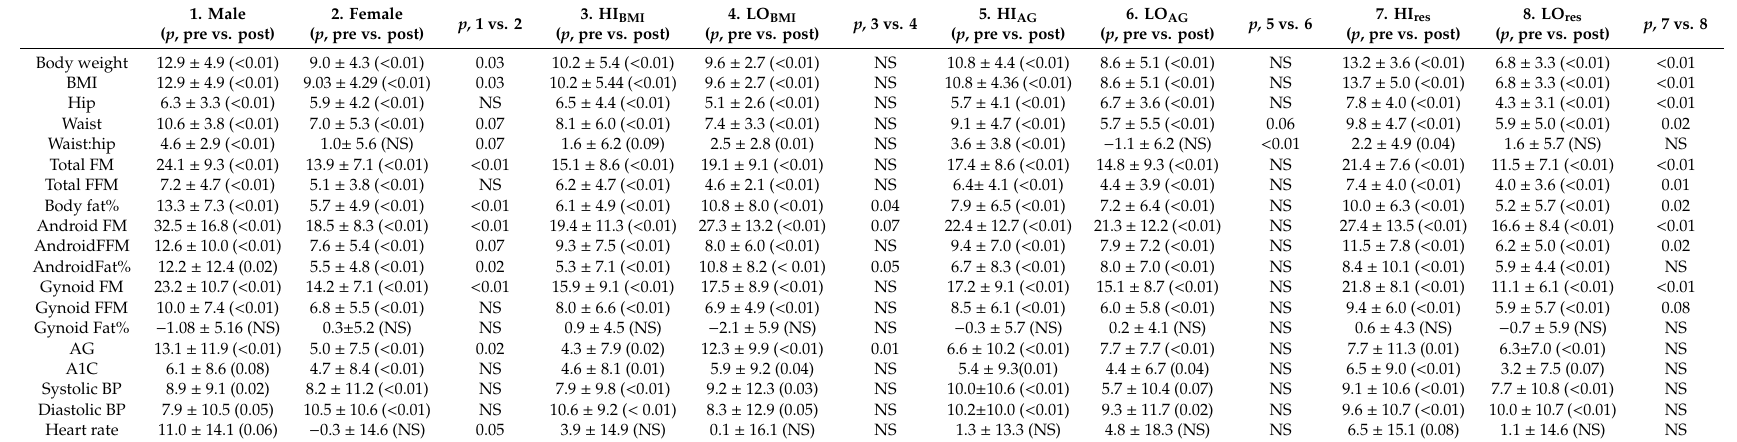
Table 4. Di ff erential changes (% change) within and between subgroups from baseline (pre weight-loss) to Week 12 (post